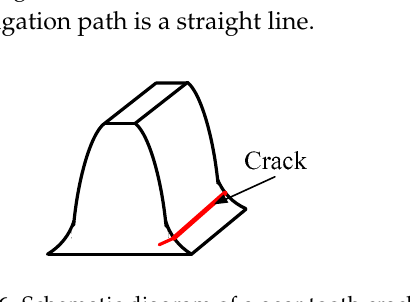
Figure 6. Schematic diagram of a gear tooth crack.